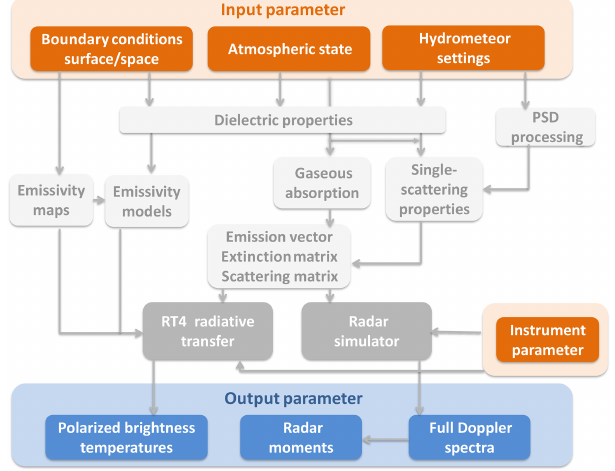
Figure 1. Flowchart of the various steps performed during a PAM- TRA simulation. Orange areas describe input parameters given by the user with the Python interface or text files. Gray boxes are the Fortran model parts where the various interaction parameters are generated and the radiative transfer or the radar simulator gets pro- cessed. Blue boxes describe the model